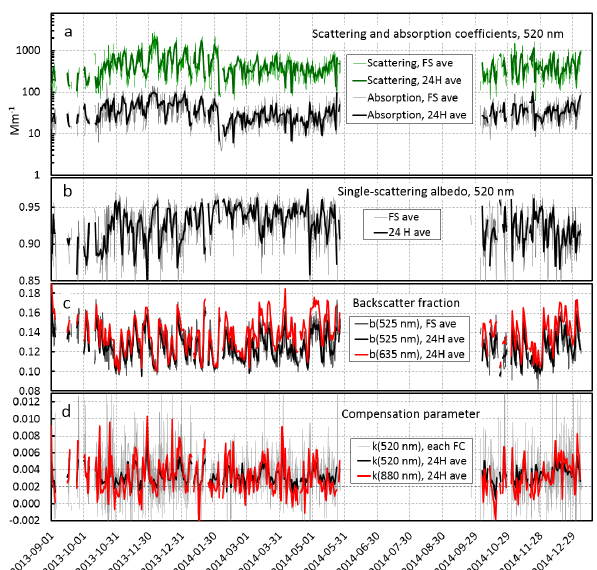
Figure 1. Overview of the data. (a) Scattering and absorption co- efficients at λ = 520nm, (b) single-scattering albedo at λ = 520nm, (c) backscatter fraction at λ = 525nm and λ = 635nm, and (d) the compensation parameter ( k ) at λ = 520nm and at λ = 880nm. In (a–c) the thin lines show the filter-spot-averaged (FS ave) values and in (d) the individual compensation parameters at each filter change (FC). The thick lines show the 24h-averaged values in all